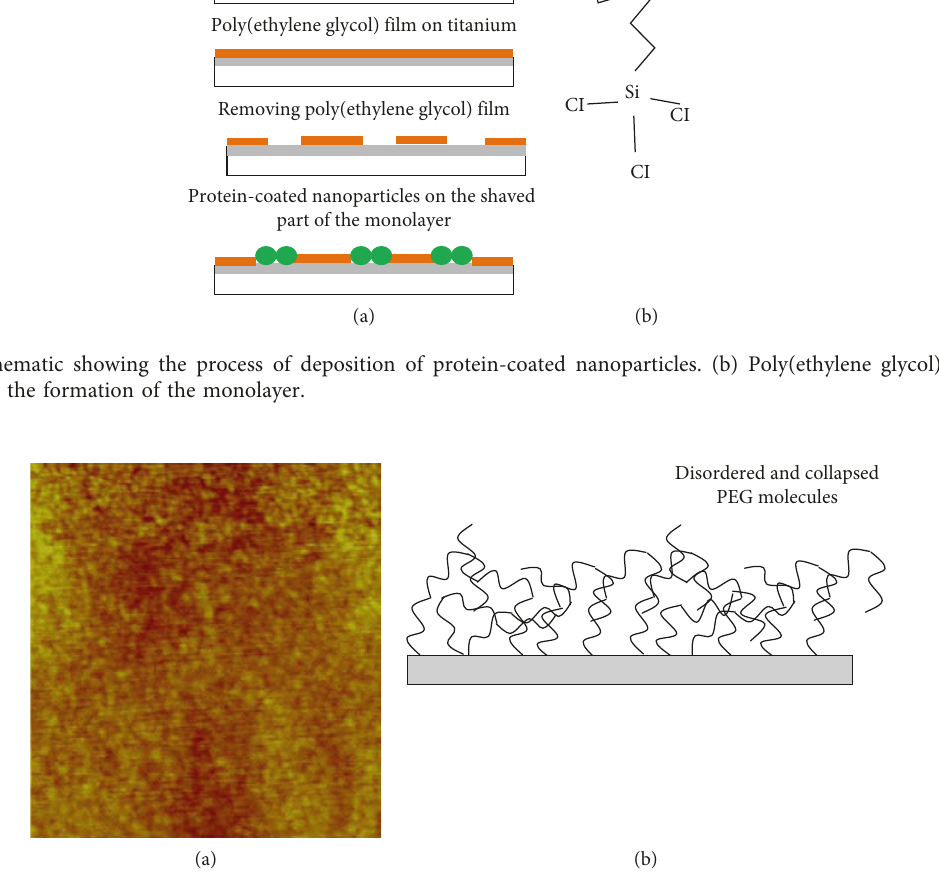
Figure 2: (a) A 1 1 μ m 2 atomic force microscopy topographic image of the poly(ethylene glycol)-silane monolayer on native oxide of × titanium. (b) A schematic of the orientation of the poly(ethylene glycol) chains.